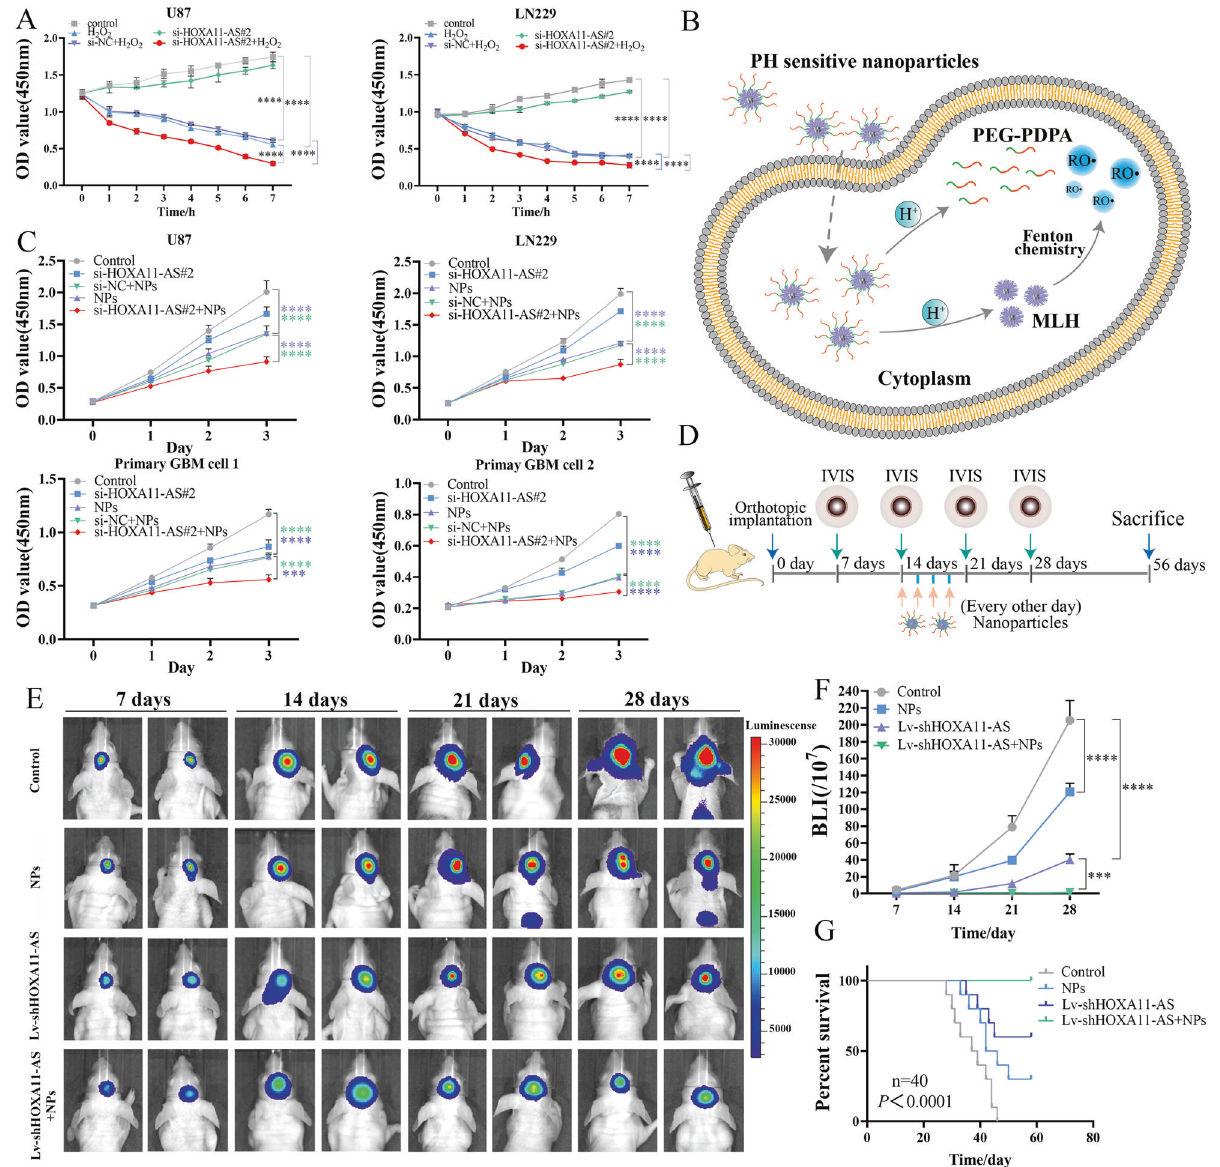
fi ed by CCK-8 assay. B Schematic representation of the use of MLH-carrying nanoparticles (NPs) for producing reactive 2 O 2 was veri oxygen species (ROS). C HOXA11-AS knockdown affecting the sensitivity of glioma and patient-derived primary GBM cells to ROS produced by NPs was determined via CCK-8 assay in vitro. D The scheme of tumor inoculation and systemic injection. Bioluminescent images ( E ) and bioluminescent intensity ( F ) of the glioma-bearing mice 7, 14, 21, and 28 days after treatment with NPs, Lv-shHOXA11-AS or cotreatment with NPs and Lv-shHOXA11-AS. G Kaplan-Meier survival analysis of mice bearing orthotopically transplanted U87 cells. Group 1: treated with PBS and Lv-shNC (control). Group 2: treated with NPs alone (13.33 μ mol/kg, i.p. injection). Group 3: treated with Lv-shHOXA11-AS alone (Intracranial implantation of U87 cells infected with HOXA11-AS shRNA lentivirus). Group 4: cotreated with Lv-shHOXA11-AS and NPs (Intracranial implantation of U87 cells transfected with Lv-shHOXA11-AS lentivirus and 13.33 μ mol/kg NPs, i.p. injection). *** P < 0.001, **** P <